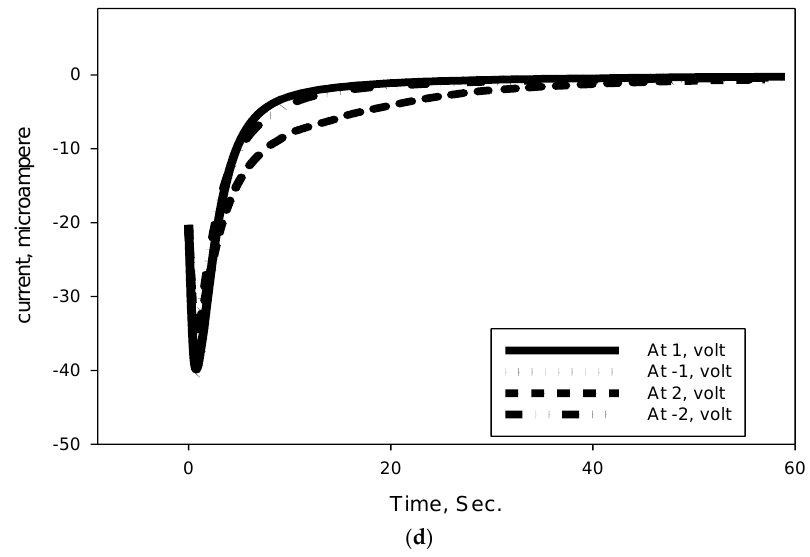
Figure 15. Electrochemical analysis of nanomaterials for dye-sensitised solar cell ( a ) cyclic voltammetry, ( b ) 20N cycles redox voltammograms, ( c ) amperometric detection, ( d ) Pulsed amperometric detection.